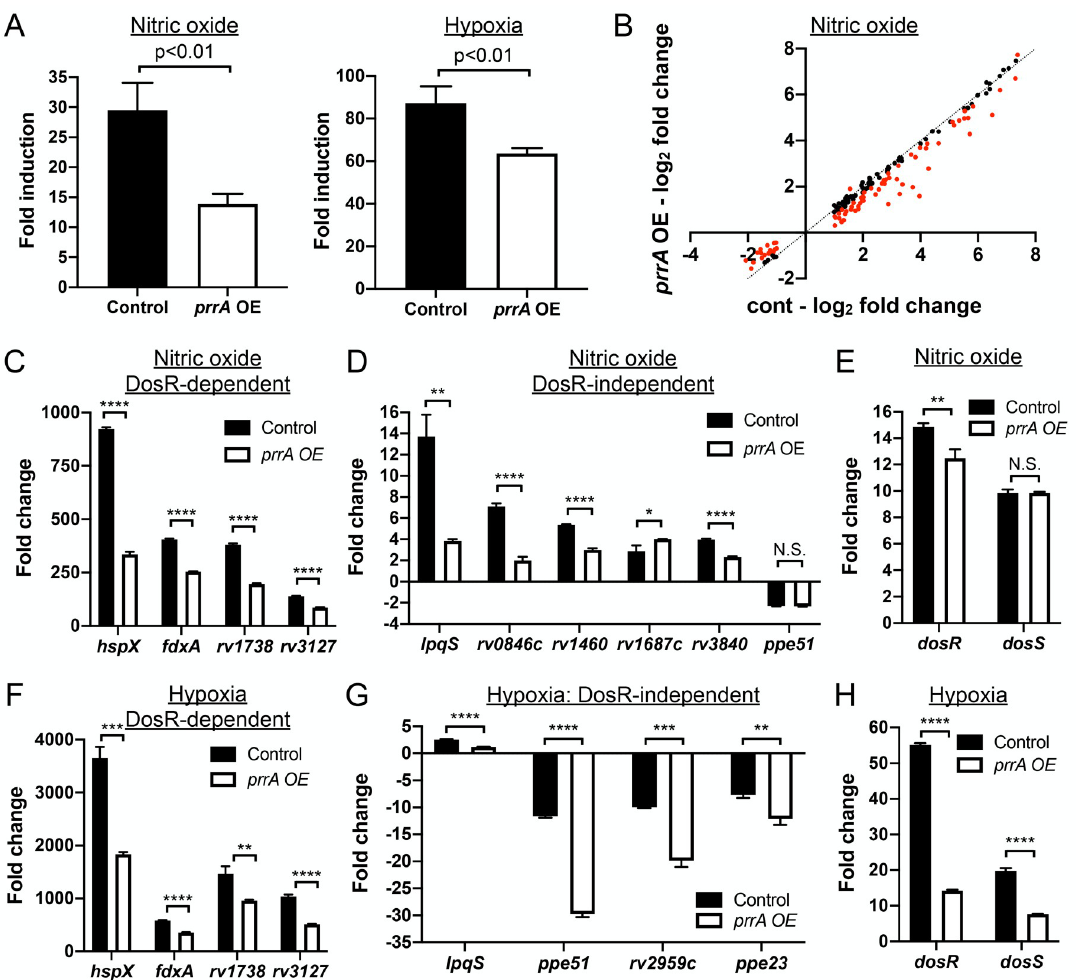
Fig 3. Perturbation of PrrA globally alters Mtb response to NO and hypoxia. (A) prrA overexpression dampens hspX’ ::GFP reporter response to NO and hypoxia. Mtb(P 606 ’:: prrA -FLAG-tetON, hspX’ ::GFP) was grown in 7H9, pH 7.0 media and treated with 0.1% ETOH (“control”) or 200 ng/ml ATC (“ prrA OE”) for 1 day before exposure to 100 μ M DETA NONOate for an additional 1 day (left panel), or to 1% oxygen for 2 days (right panel). EtOH or ATC was maintained as appropriate throughout the exposure. Reporter GFP signal was analyzed by flow cytometry, and fold induction is in comparison to control conditions (no added DETA NONOate and atmospheric O 2 respectively). Data are shown as means ± SD from 3 experiments. p-values were obtained with an unpaired t-test. (B-E) Overexpression of prrA globally modulates Mtb response to NO. Log-phase Mtb(P 1 ’:: prrA -FLAG - tetON, rv2390c’ ::luciferase) was grown in 7H9, pH 7.0 media and treated with 0.1% EtOH or 200 ng/ml ATC for 2 hours, before exposure to 7H9, pH 7.0 ± 100 μ M DETA NONOate for 4 hours in the continued presence of EtOH or ATC as appropriate, and samples extracted for RNA sequencing analysis (B) or qRT-PCR (C-E). In (B), log 2 -fold change compares gene expression in the 7H9, pH 7 + 100 μ M DETA NONOate condition versus the 7H9, pH 7 control condition for each of the EtOH (“cont”) or ATC (“ prrA OE”) treatment sets. Genes marked in red had a log 2 -fold change difference � 0.25 between the ATC and EtOH treatment sets (p < 0.05, FDR < 0.01 in both sets, with log 2 -fold change � 1 in the EtOH set). In (C-E), fold change compares gene expression in the 7H9, pH 7 + 100 μ M DETA-NONOate condition versus the 7H9, pH 7 control condition for each of the EtOH (“control”) or ATC (“ prrA OE”) treatment sets. sigA was used as the control gene, and data are shown as means ± SD from 3 technical replicates. p-values were obtained with an unpaired t-test. N.S. not significant, � p < 0.05, �� p < 0.01, ���� p < 0.0001. (F-H) prrA overexpression inhibits induction of multiple hypoxia-responsive genes. qRT-PCR of Mtb(P 1 ’:: prrA - FLAG - tetON, rv2390c’ ::luciferase) in 7H9 pH 7.0 media treated with 0.1% EtOH (“control”) or 200 ng/ml ATC (“ prrA OE”) for 2 hours under aerated conditions before exposure to 1% oxygen for an additional 4 hours, in the continued presence of EtOH or ATC as appropriate. Fold change compares the 1% oxygen condition at 4 hours to the aerated 0 hour time point. sigA was used as the control gene, and data are shown as means ± SD from 3 technical replicates. p-values were obtained with an unpaired t-test. �� p < 0.01, ��� p < 0.001, ���� p <